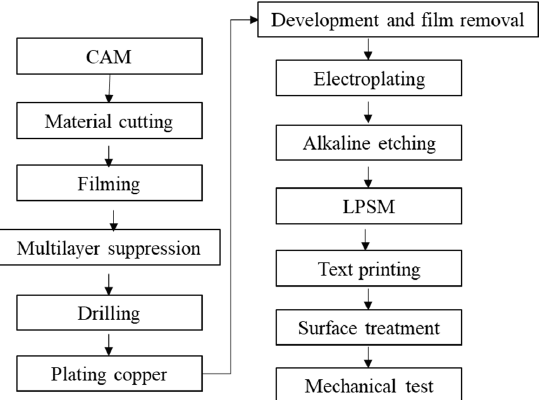
Figure 8. Process flow chart of a typical printed circuit board (PCB) manufacturing enterprise. (Note: CAM: Computer aided manufacturing; LPSM: liquid photoimageable solder mask).